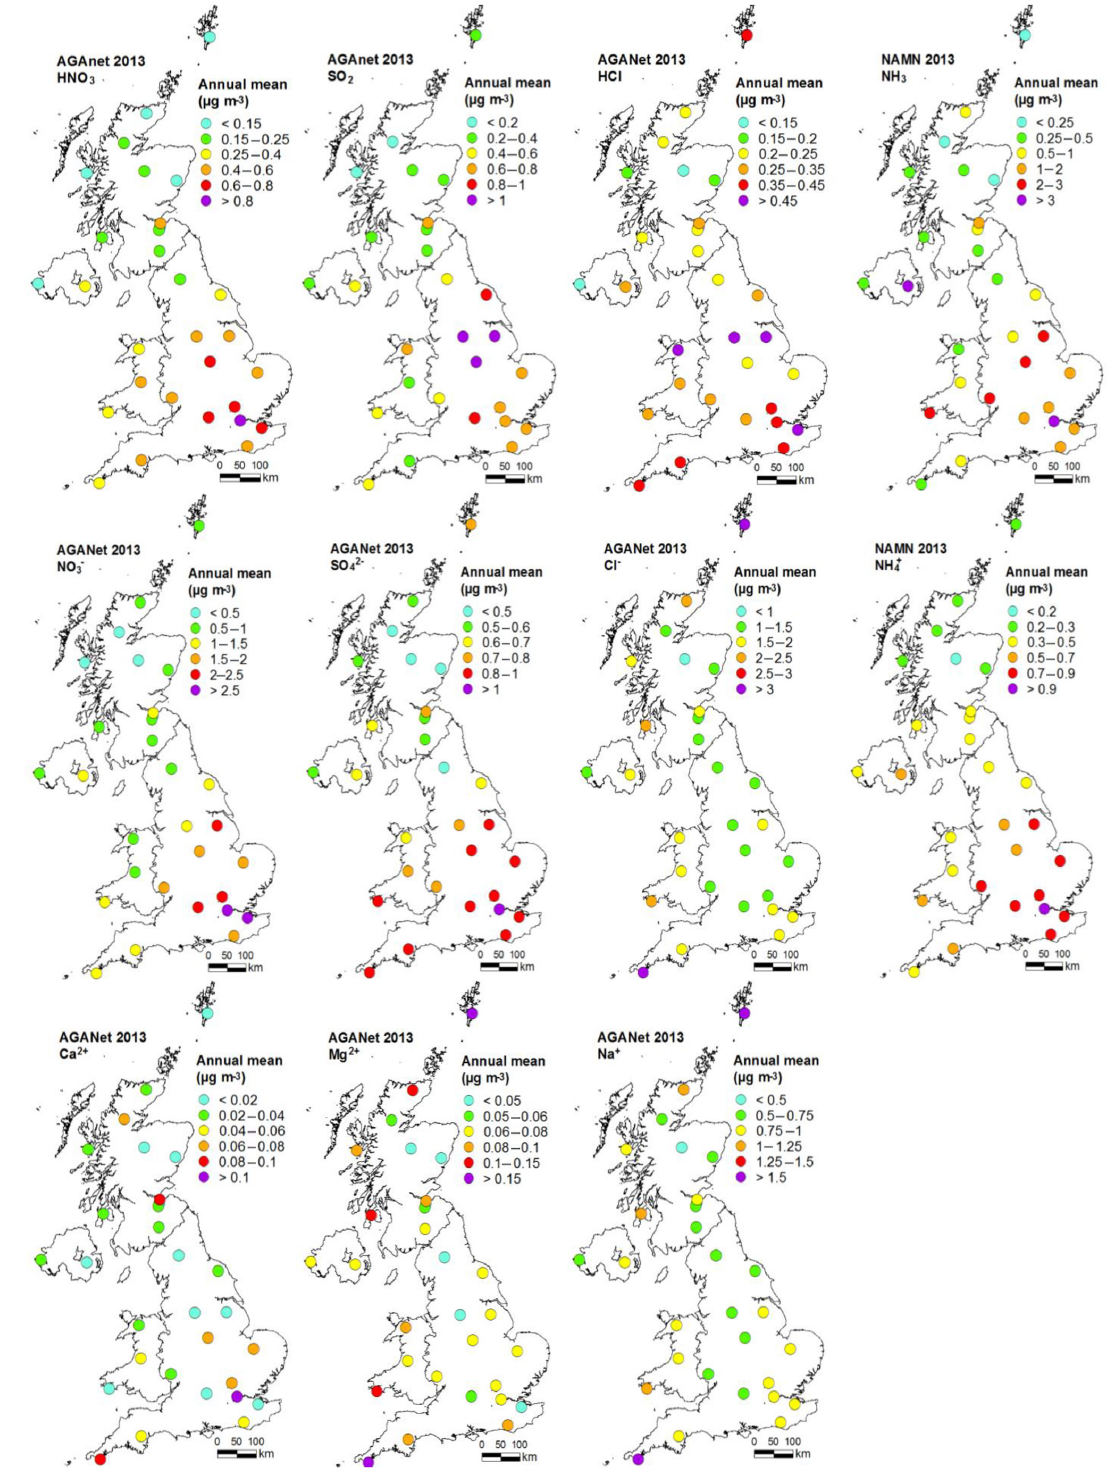
Figure 6. Annual mean monitored acid gas (HNO 3 , SO 2 , HCl) and aerosol (NO − the UK Acid Gas and Aerosol Monitoring Network (AGANet) across the UK from annual averaged monthly measurements made in 2013. NH 3 and NH + measured at the same time from the UK National Ammonia Monitoring Network (NAMN, Tang et al., 2018) are also shown 4 alongside for